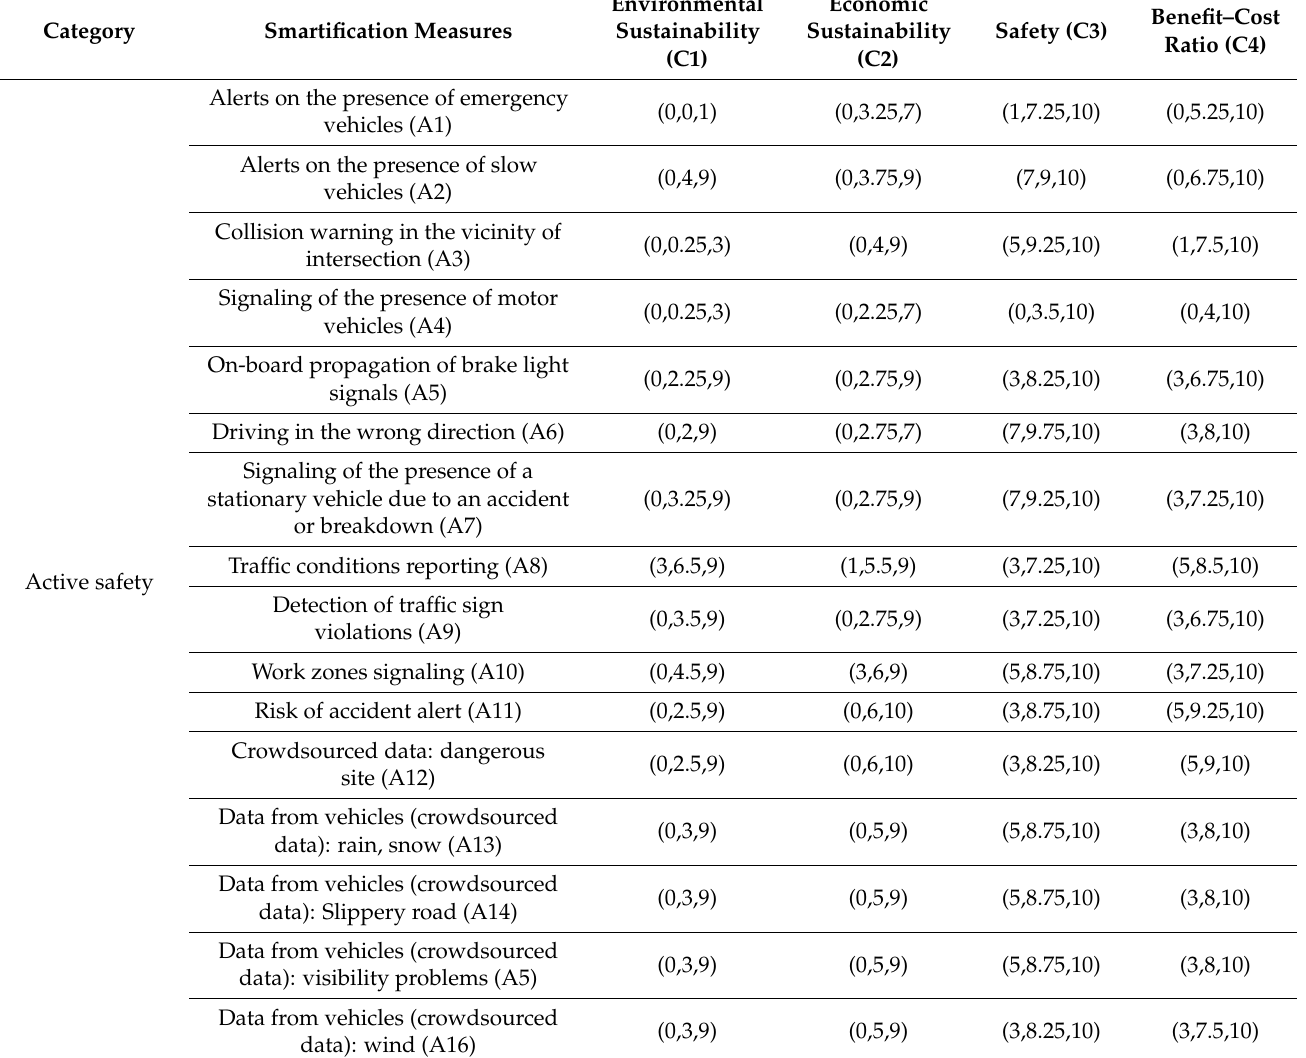
Table 4. The fuzzy decision matrix for 27 smartification measures based on four decision-making